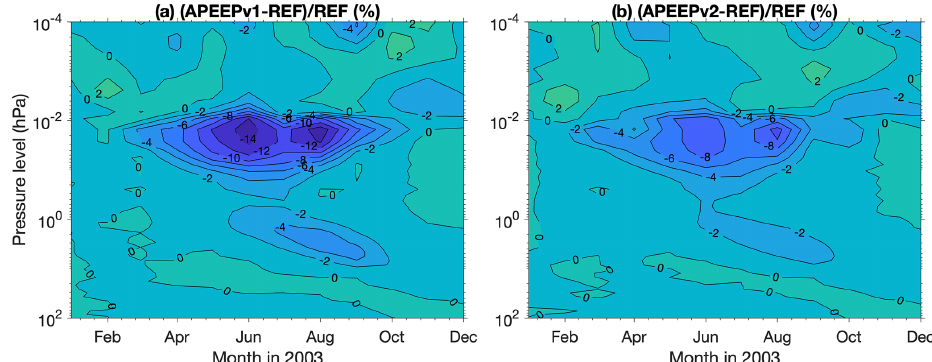
Figure 10. Southern Hemisphere (SH) polar-cap ozone monthly means for the year 2003. (a) Relative differences between simulations using APEEPv1 and no MEE forcing. (b) Relative differences between simulations using APEEPv2 and no MEE forcing. Note that panel (b) shows the same data as Fig. 3b, but the contour lines are